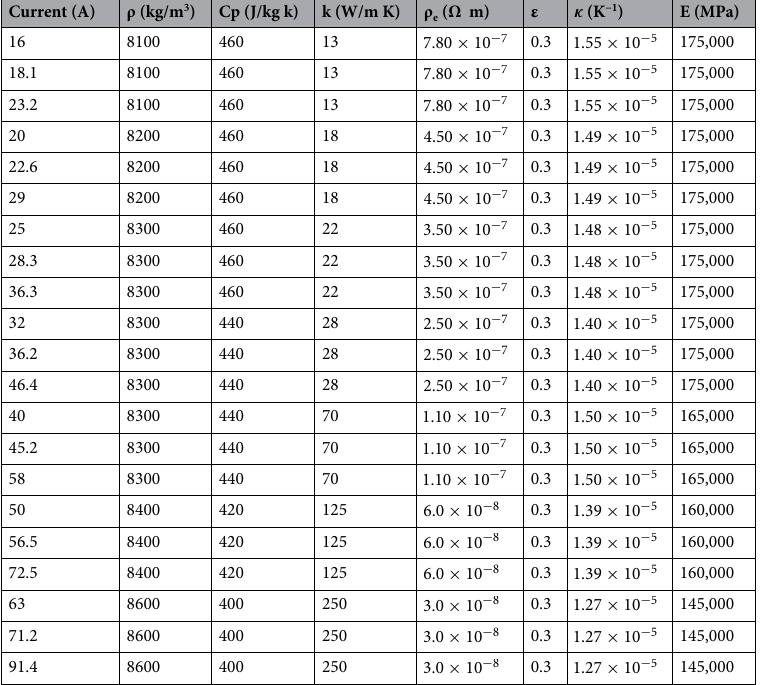
Table 4. The details of Input parameters used for experimental validation of the NMML model.